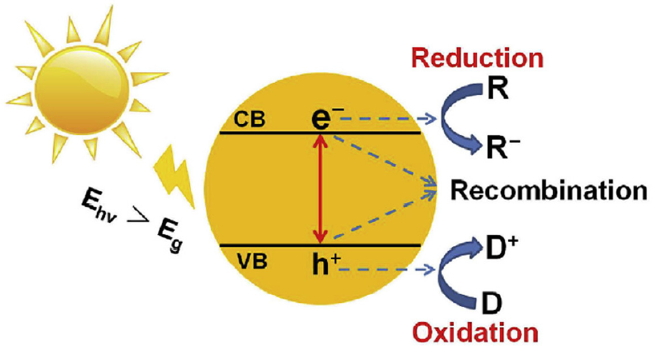
Figure 9. Basic mechanism of ZnO photocatalysis. Reprinted/adapted with permission from Ref. [27]. Copyright© 2022, Elsevier B.V.